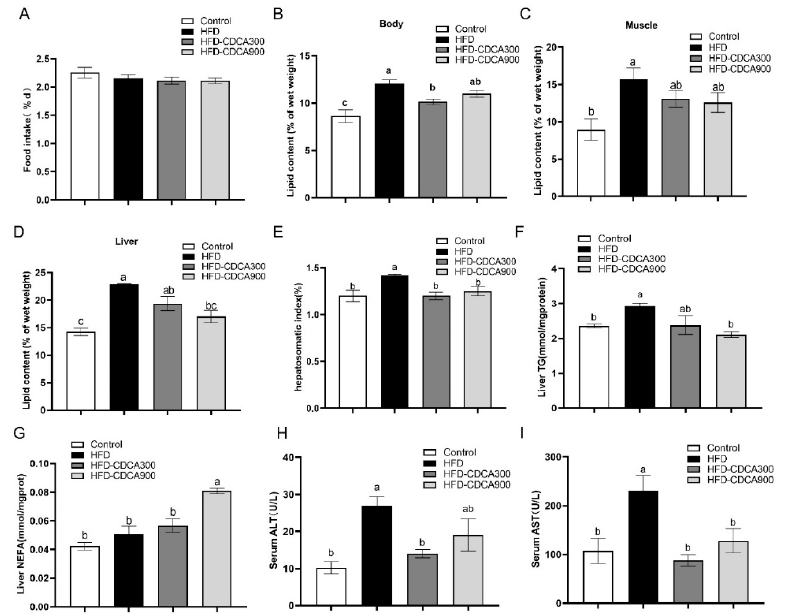
Figure 1. Effects of HFD and supplementation of CDCA on: ( A ) Food intake; ( B – D ) lipid content of whole body, muscle, and liver; ( E ) hepatosomatic index; ( F , G ) TG and NEFA of liver; ( H , I ) ALT and AST of serum in large yellow croakers. The data are provided as means ± SEMs ( n = 3) and were analyzed using Duncan’s multiple range test. The letters a and b indicate that there is a significant difference between means, p < 0.05.